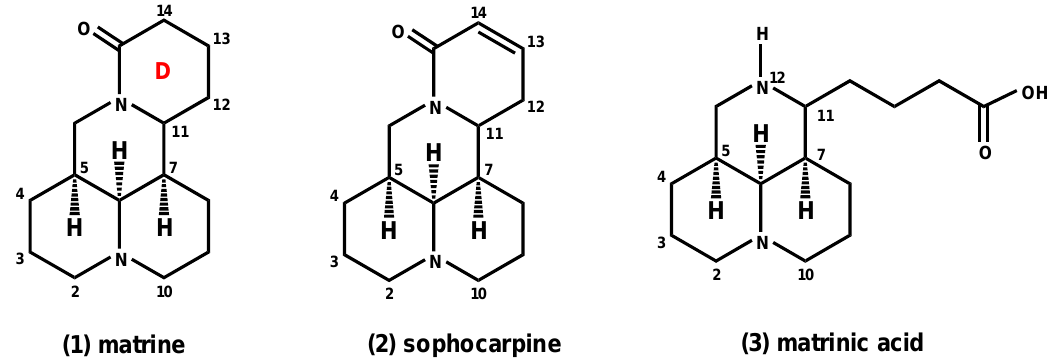
Figure 1. Chemical structures of matrine ( 1 ), sophocarpine ( 2 ), and matrinic acid ( 3